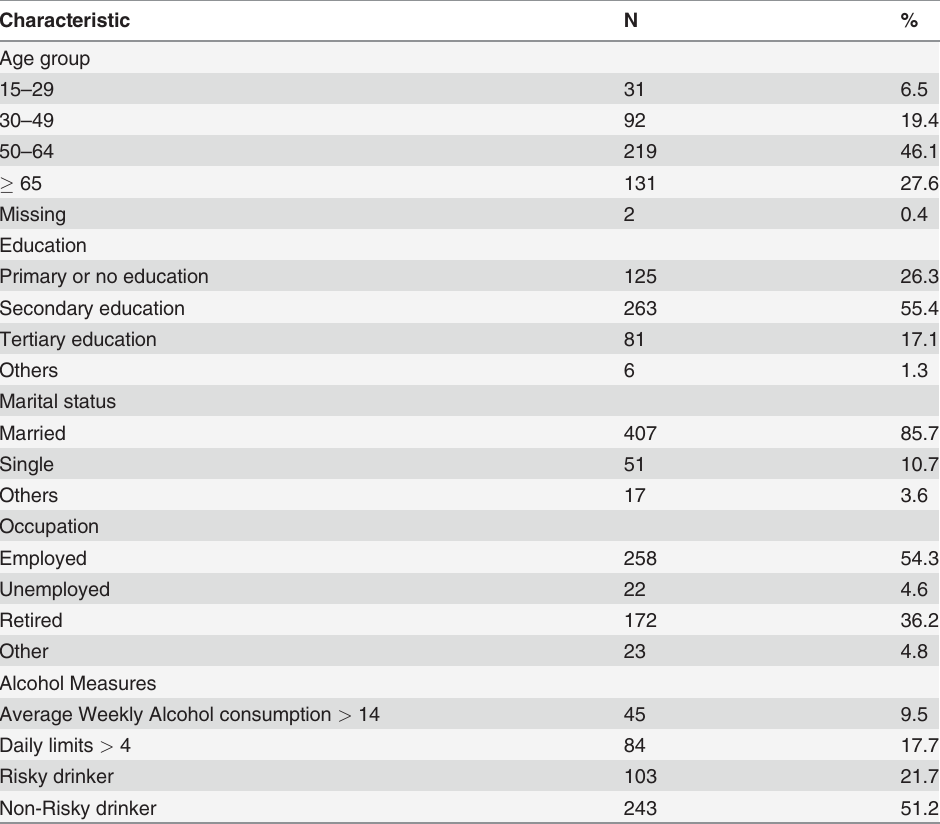
Table 1. Characteristics of Subjects Study Sample (N = 475).